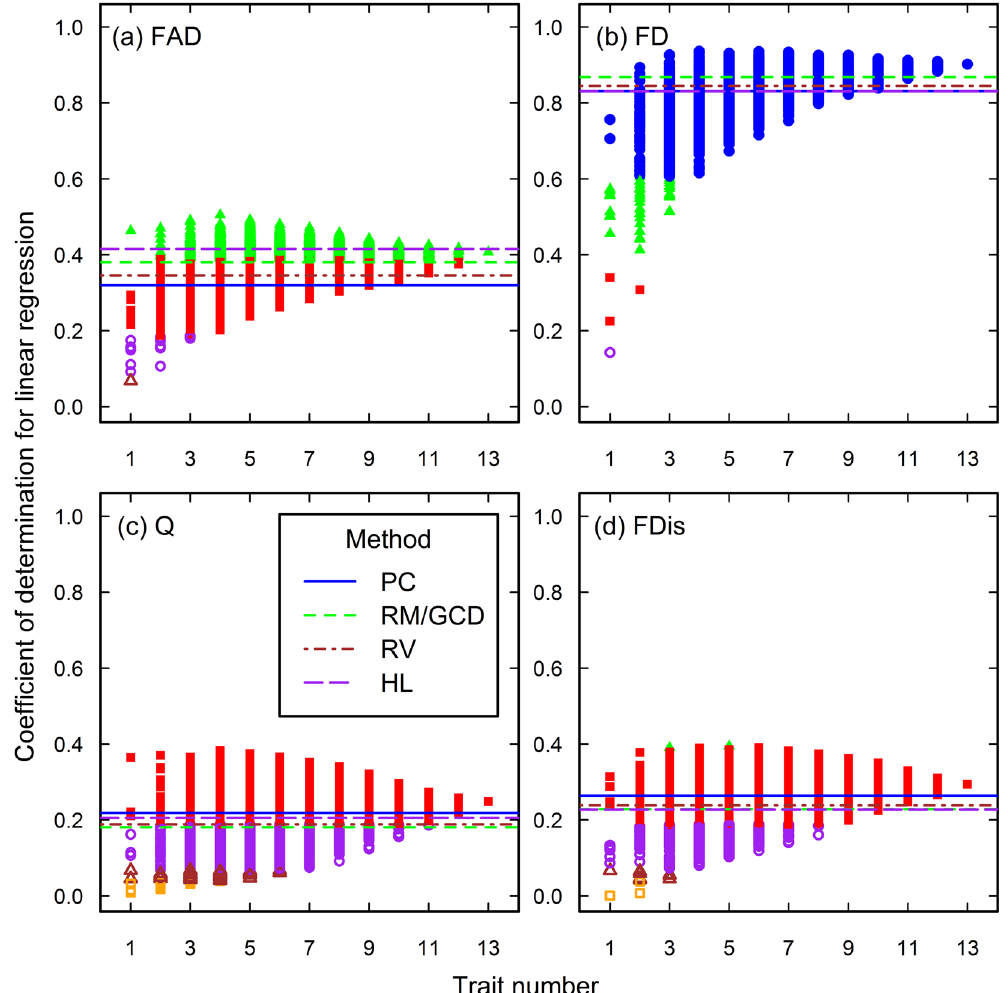
Figure 3. The closeness of associations between species richness and functional diversity in the Arizona data set. See the caption of Fig. 1 for the meanings of each plot, line and